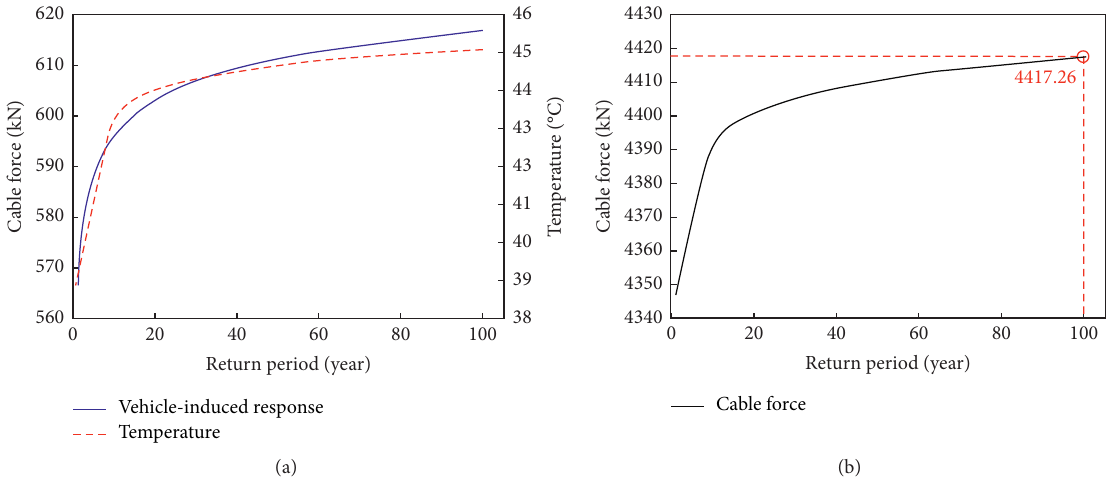
Figure 17: Variation of the predicted extreme value with return periods: (a) the vehicle-induced response for NJ21 and temperature; (b) the total cable